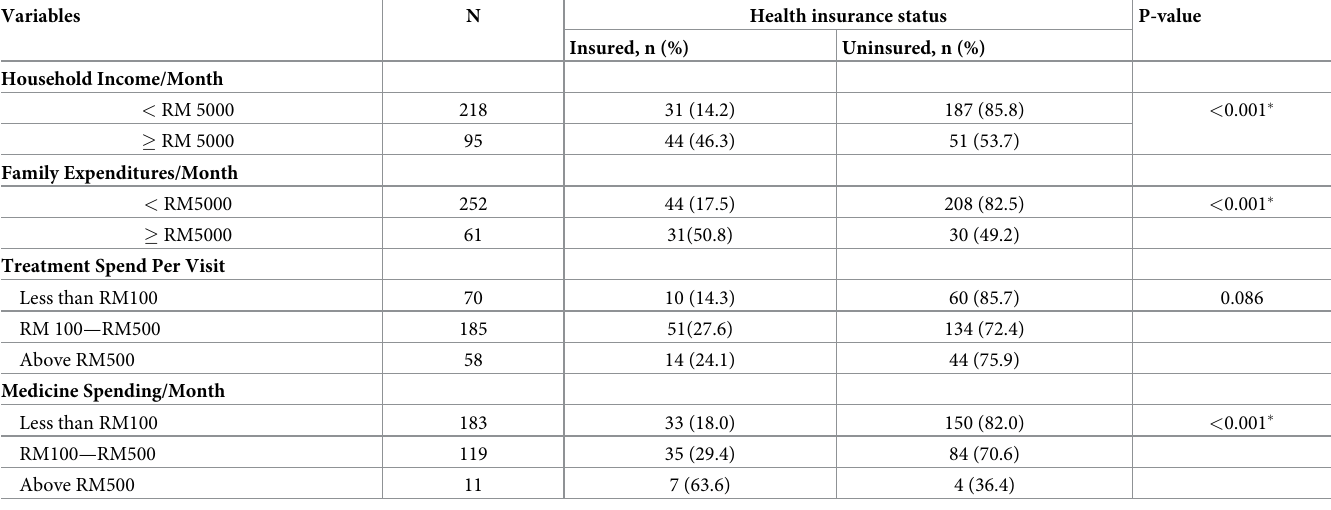
Table 4. Association between health insurance status, income and health